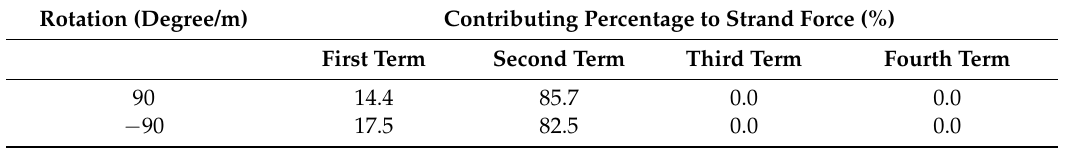
Table 2. Contribution of each term of Equation (22) in the case of rotation of the steel strand. Rotation (Degree/m) Contributing Percentage to Strand Force (%) First Term Second Term Third Term Fourth Term 90 14.4 85.7 0.0 0.0 − 90 17.5 82.5 0.0